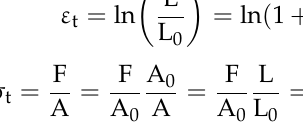
Table 5. Engineering vs. true stress at the tensile strength. Coupon Engineering Stress R m (MPa) Al1 229.8 Al2